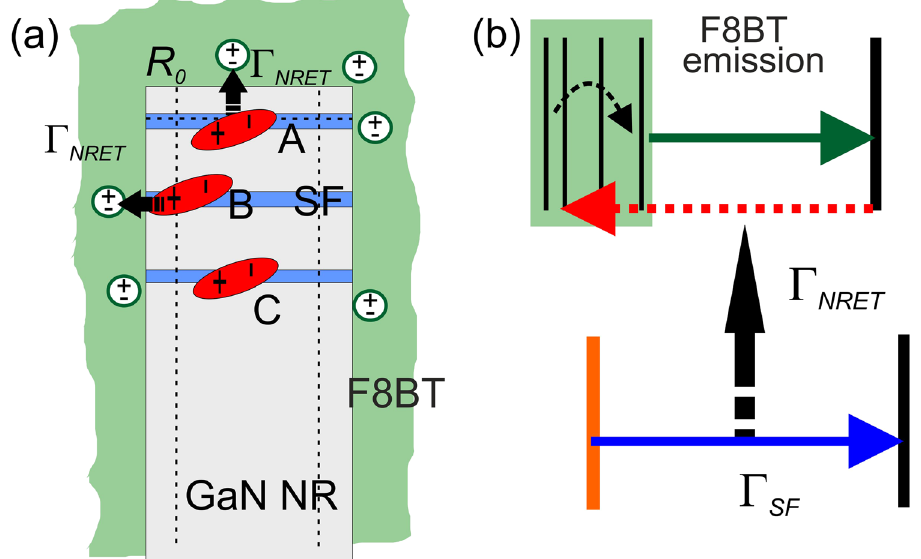
Figure 5. ( a ) Drawing of the GaN NR coated by polyfluorene. Three possible spatial localization for the exciton confined within the SF QW-like potential at low temperatures are denoted by letters A, B and C. ( b ) Schematically shown is the NRET process from the bound SF excitons to the organic polymer followed by relaxation to the ground state and